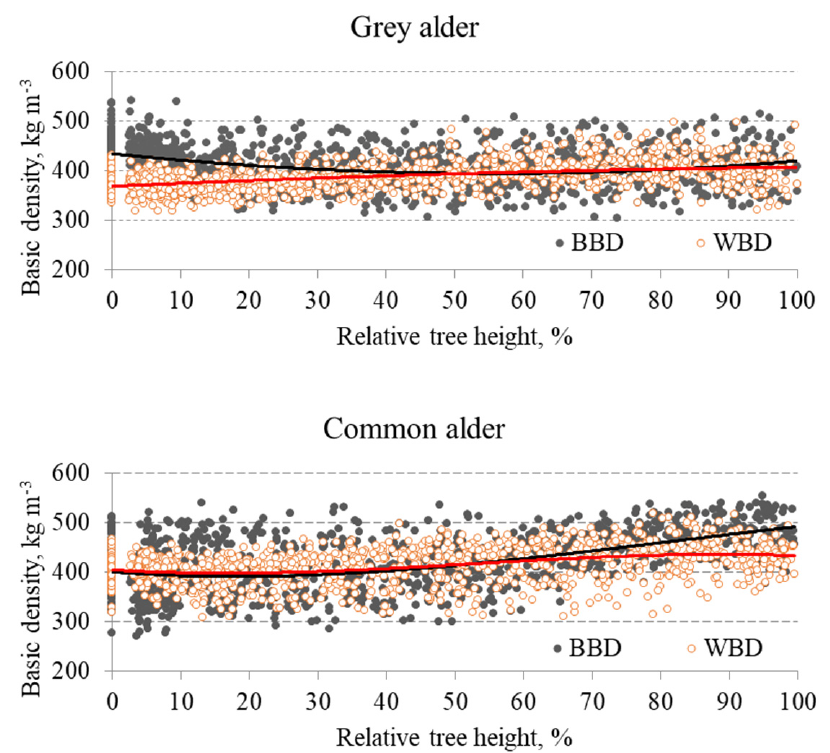
Figure 3. Axial variation of wood basic density (WBD) (red solid line) and bark basic density (BBD) (black solid line) for gray alder and common alder stems. Unlike aboveground components, the density of all belowground components was sig- nificantly higher for gray alder than common alder. For gray alder, the BD of the stumps, av- erage coarse roots, and average small roots were 413.88 ± 7.43 kg m − 3 , 358.53 ± 4.62 kg m − 3 , and 317.40 ± 3.93 kg m − 3 , respectively. The corresponding values for common alder were 381.26 ± 8.01 kg m − 3 , 292.93 ± 8.41 kg m − 3 , and 230.55 ± 4.73 kg m − 3 , respectively. The dominant trend for within-stem density variation for both alder species was that BD was lower at the base of the stem and increased toward the top (Figure 4). However, according to our data, it is evident that gray alder has more homogeneous wood than common alder because BD variation across the stem was less pronounced for this tree species. The lowest BD of gray alder wood was observed in the core of the bottom part of the stem, steadily increasing toward the bark. An increase in BD from pith to bark along the stem was a visible tendency for gray alder. For common alder, the cone-shaped core with lower BD at the base of the stem was relatively smaller but more distinctive than for gray alder. The wood BD for common alder also increased in a radial direction. However, the tendency of the formation of the less dense outer layer of the wood can be observed later along the stem, except for the top section, where density is the